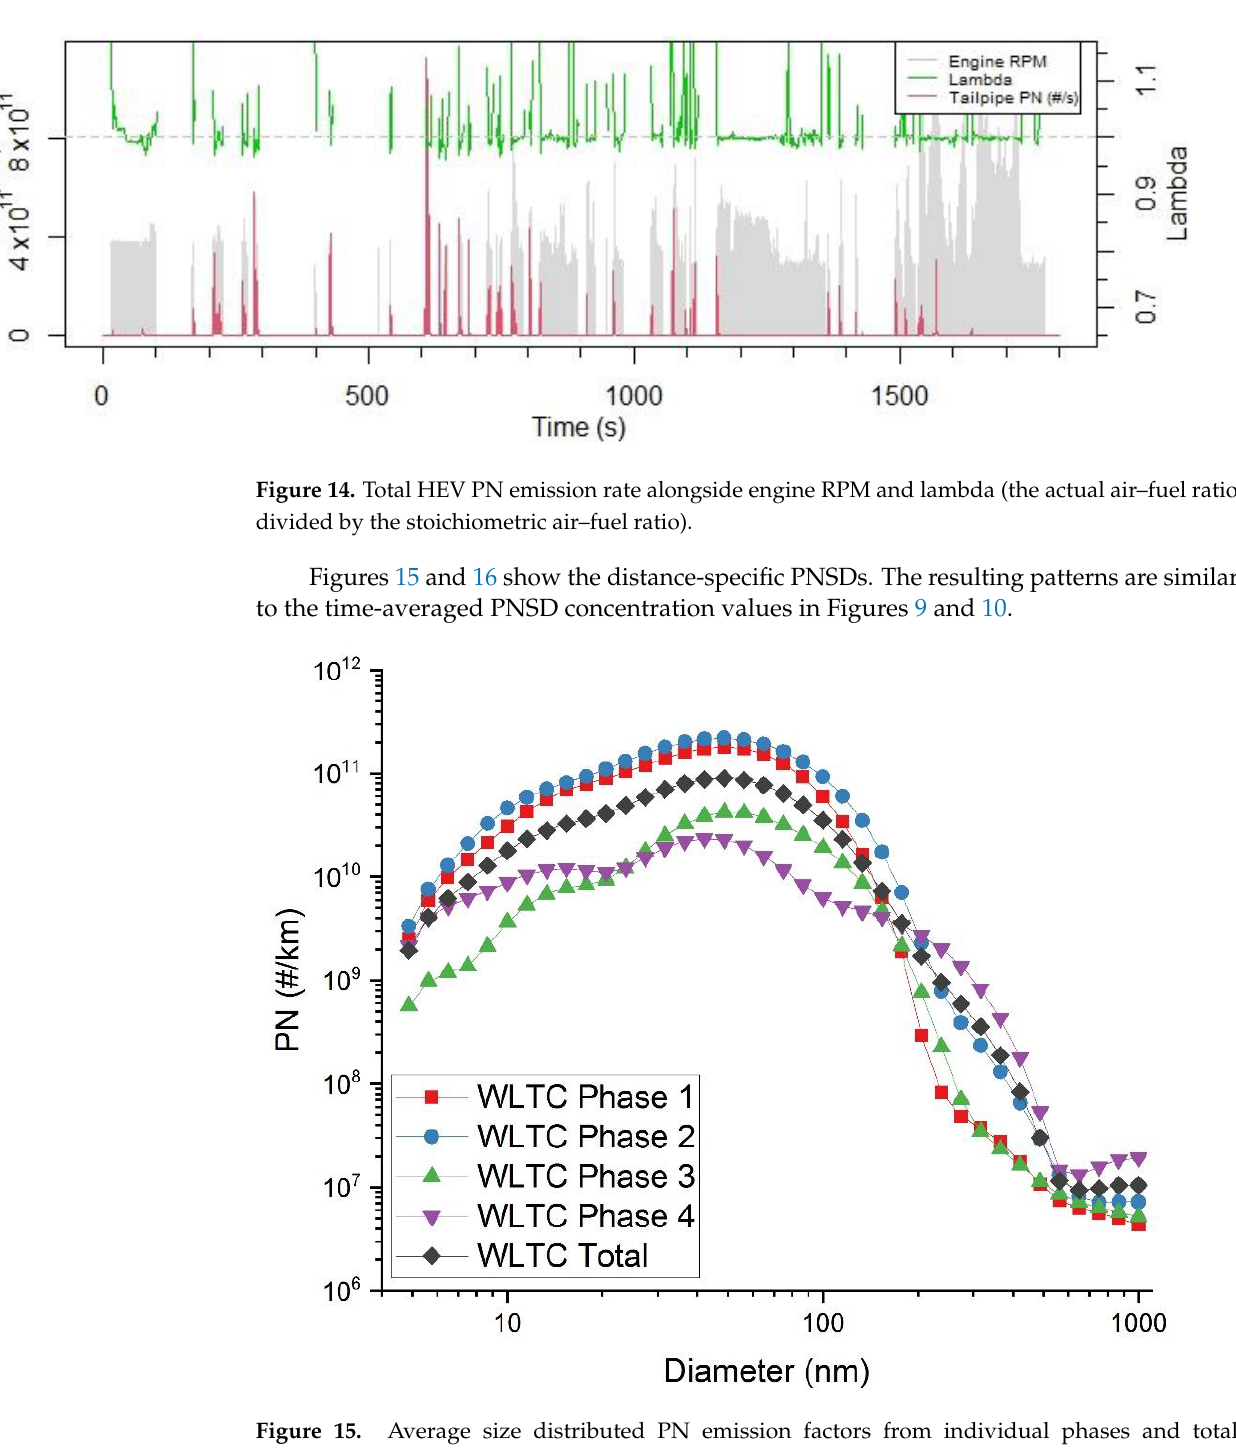
Figure 13. Example of one RDE test PNSD with time for all engine stabilised operation. Engine RPM is indicated in blue at 3 × 10 3 times scale.